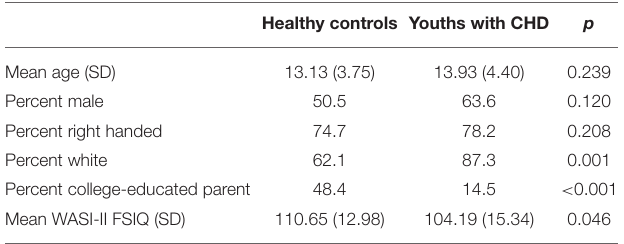
TABLE 2 | Cerebellar and prefrontal region structural differences between youth with CHD and healthy controls. Structure Healthy controls Youths with